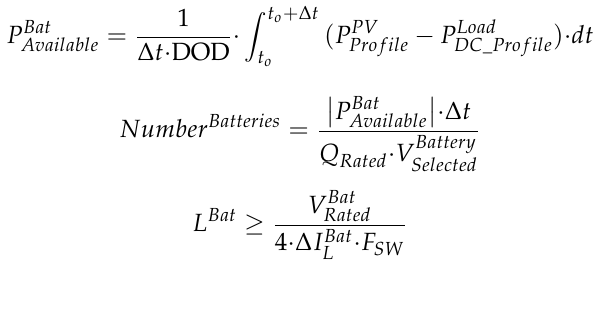
Figure 2. Battery Energy Storage System (BESS): ( a ) Reference profiles of PV generation (P ProfilePV ), power consumed by the loads ( P DC_ProfileLoad ) and time of use (TOU) tariff of electricity in the MG; ( b ) Electrical diagram of the BESS.